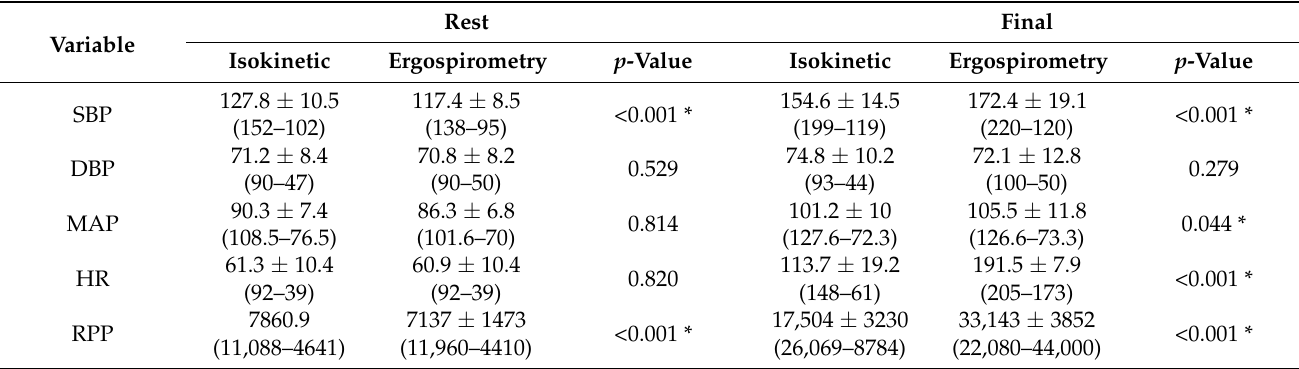
Table 2. Comparison of the cardiovascular values achieved by the global sample (n = 63) at the end of the isokinetic protocol and treadmill